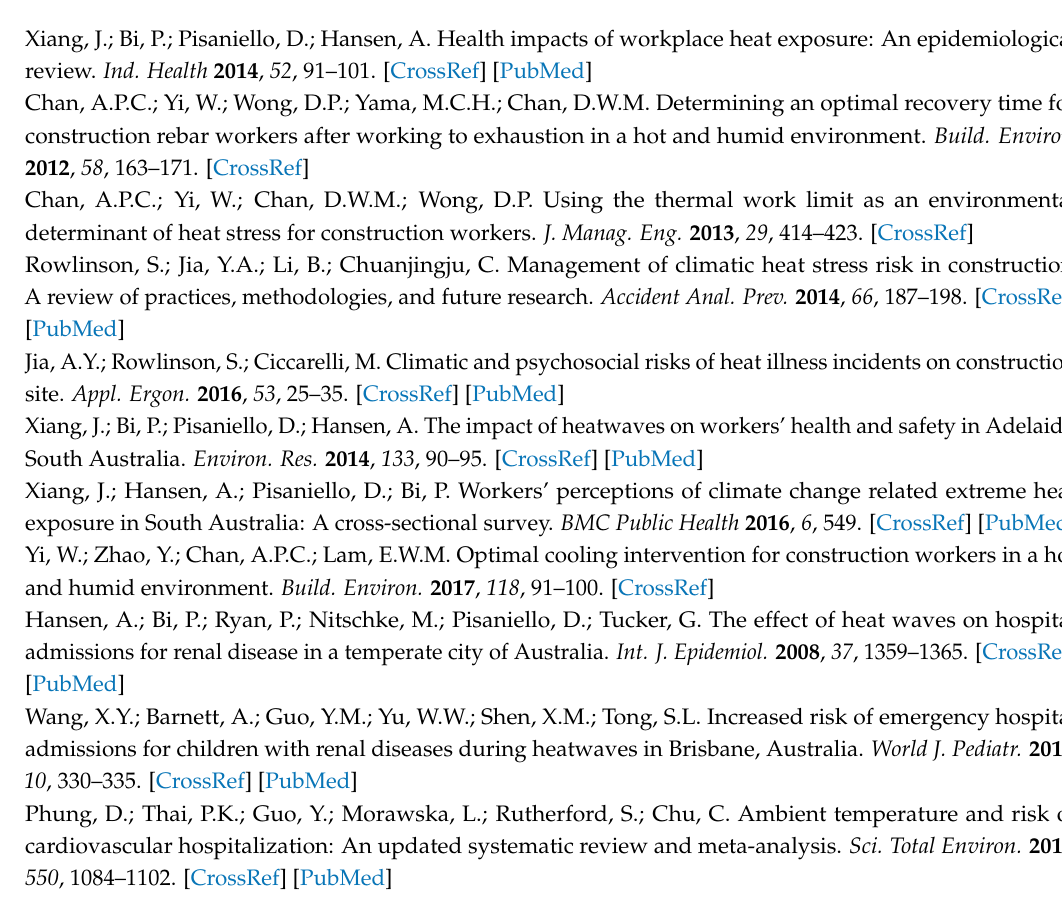
Figure S1, The impacts of physical exertion of work (a) and time spent outside (b) on respondents’ heat stress levels (N = 1719), Figure S2, Heat relief measures taken by heat stressed respondents (N = 1719) at work by their levels of physical exertion at work, Table S1, Number of invited survey participants, drop-out and response rates for the two survey waves in May (Wave 1) and October 2014 (Wave 2), Table S2, Variables included in logit models as determinants of heat relief measures, Table S3, Differences in core demographics and heat relief measures of respondents in survey Wave 1 and Wave 2, Table S4, Correlation matrix of independent variables regarding demographic and employment background, and heat stress (as described in Table S2), Table S5, Results of saturated logit models with interactions between core demography variables—Hydration, Table S6, Results of saturated logit models with interactions between core demography variables—Cooling, Table S7, Results of saturated logit models with interactions between core demography variables—Resting, Table S8, Results of saturated logit models with interactions between core demography variables—Changing